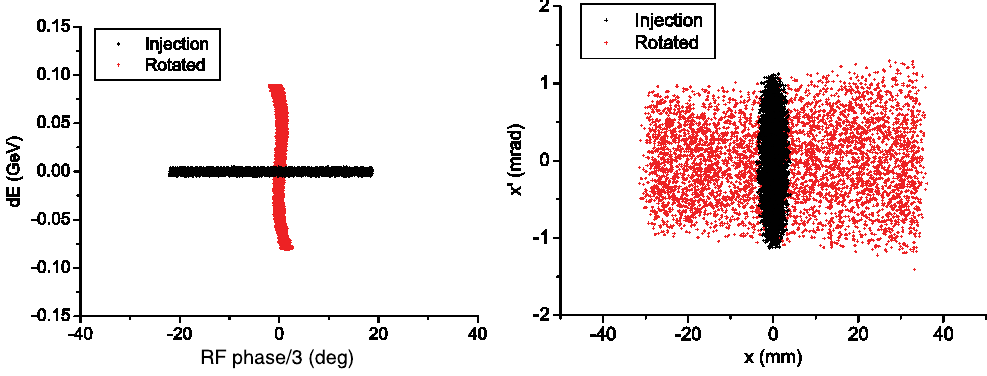
FIG. 2. Phase-space plots before and after bunch